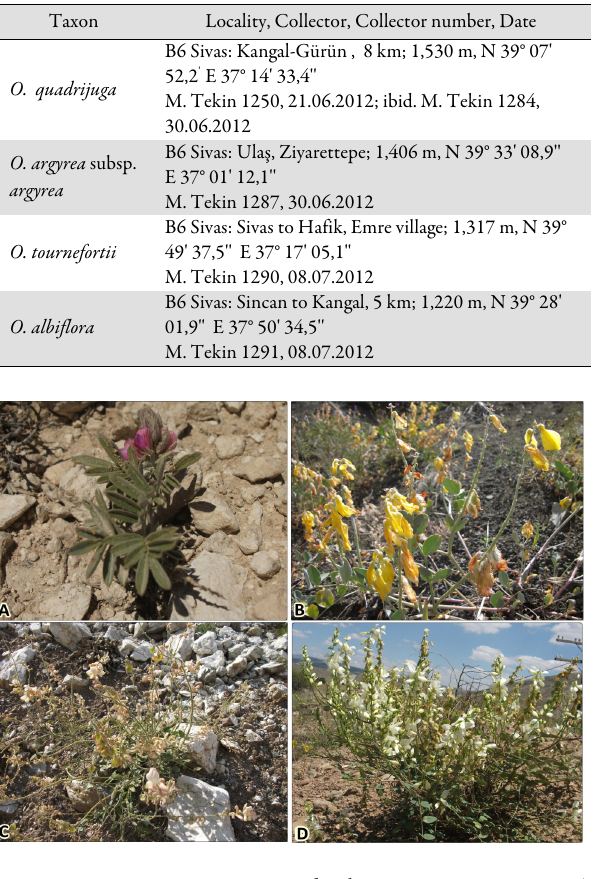
Fig. 1. General view of examined Onobrychis taxa in natural habitat: A) O. quadrijuga ; B) O. argyrea subsp. argyrea ; C) O. tournefortii ; D) O.